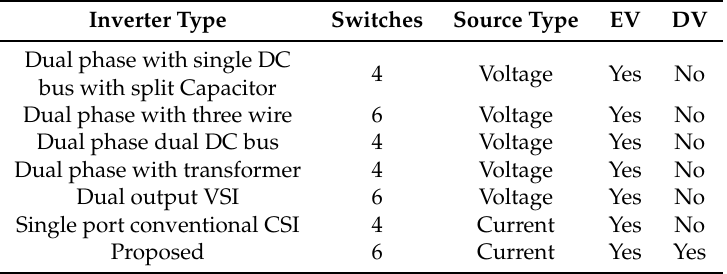
Table 2. Comparison of